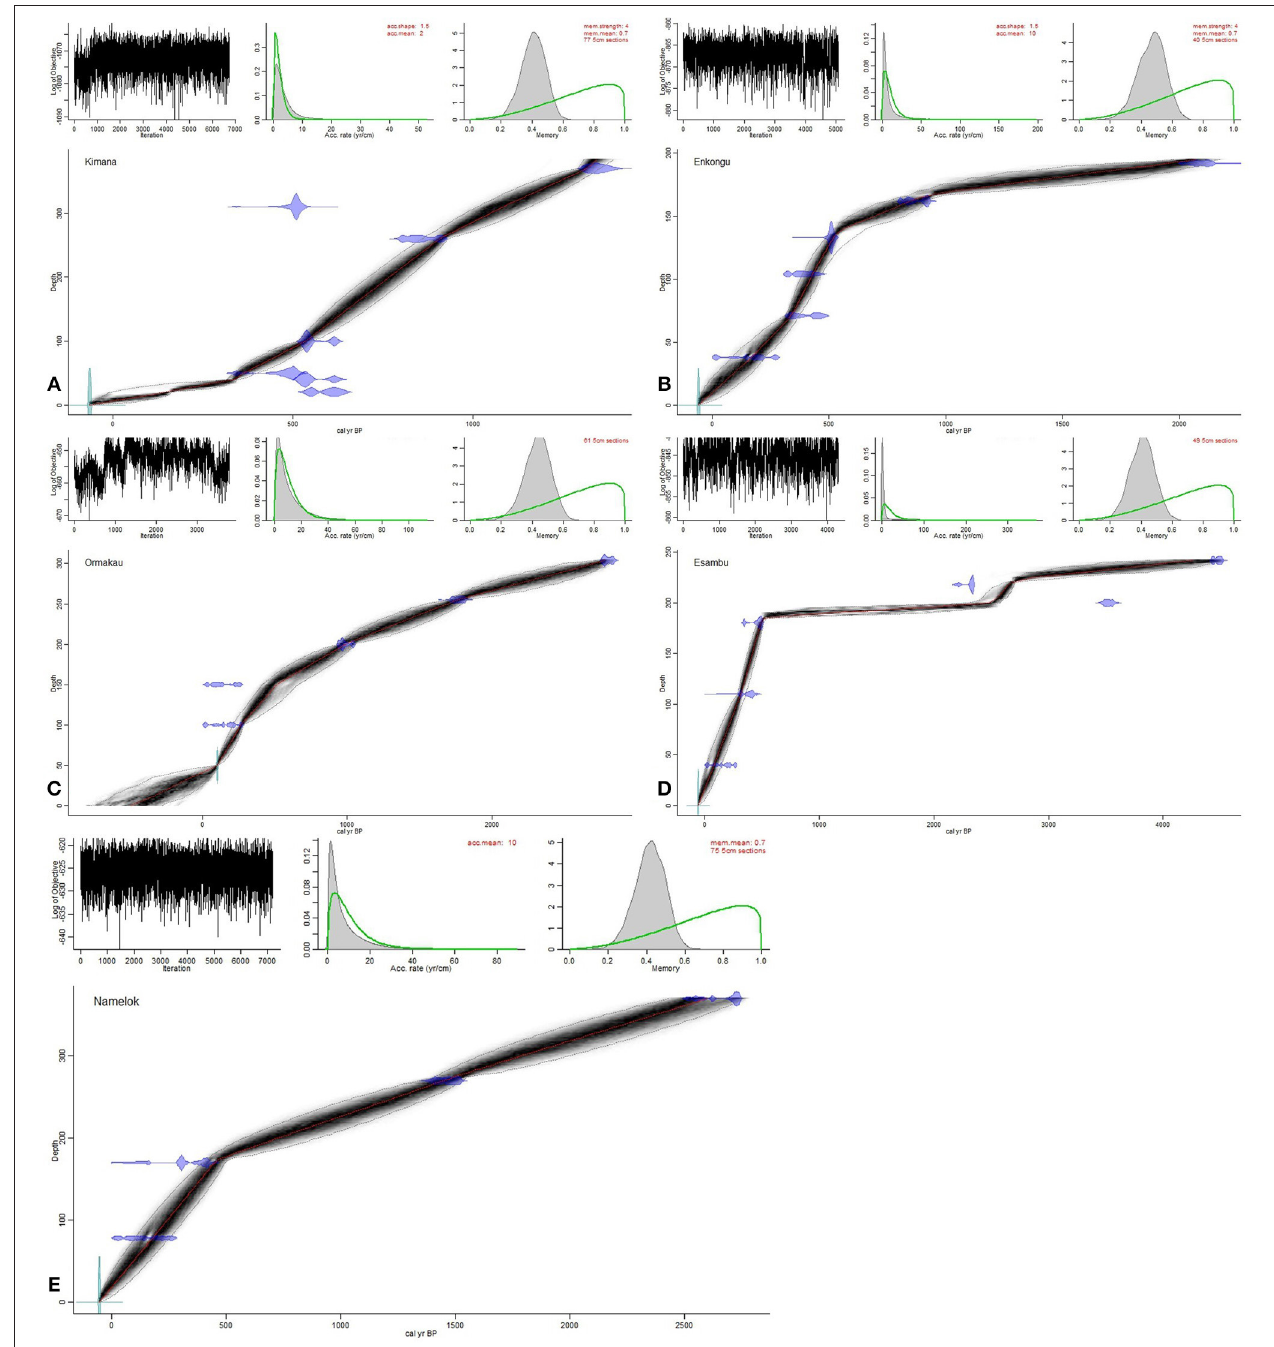
FIGURE 2 | BACON age-depth models of (A) Kimana, (B) Enkongu, (C) Ormakau, (D) Esambu, and (E) Namelok wetlands from the radiocarbon dates acquired from the various labs.